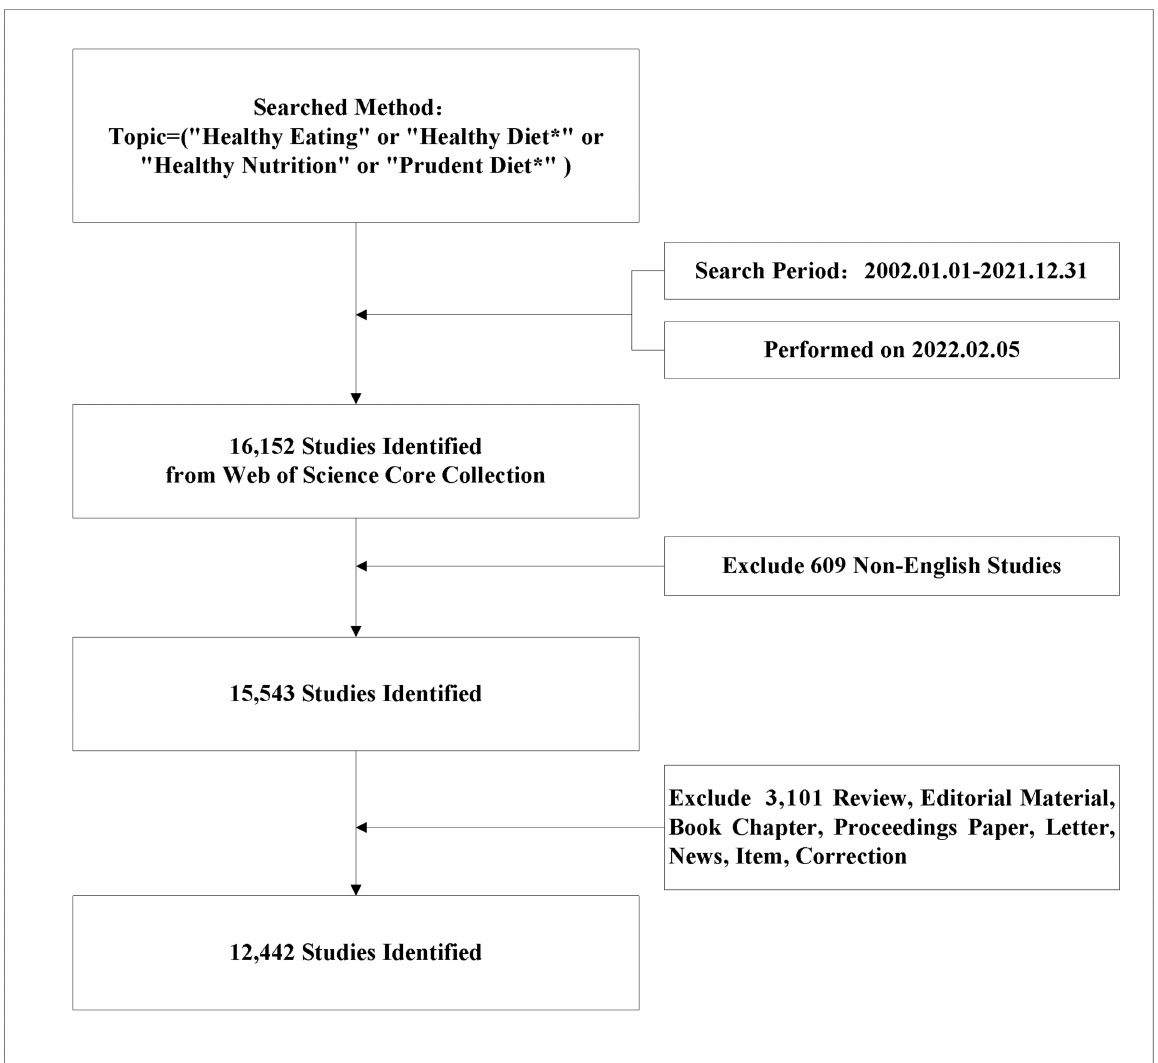
Figure 1. The flowchart of the literature search